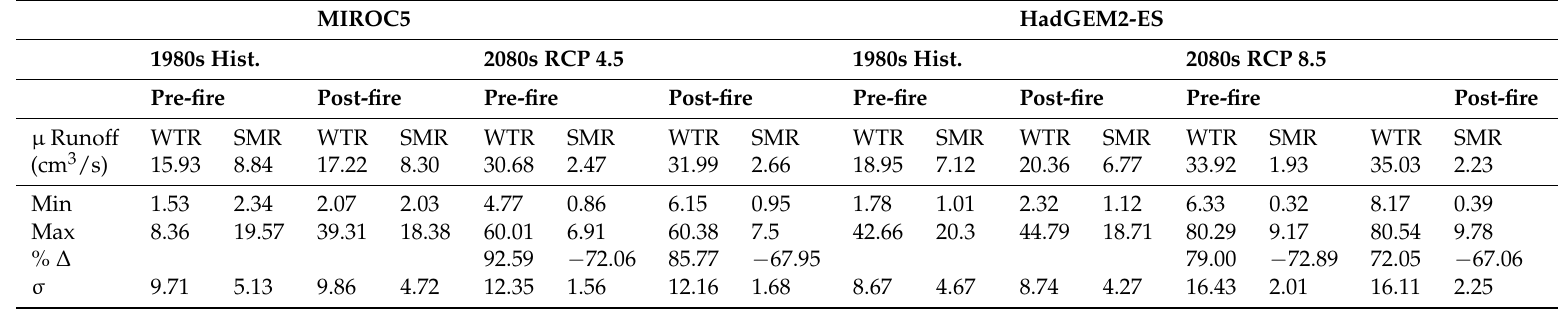
Table 4. Seasonal flows before and after forest cover reduction in the 1980s and 2080s for MIROC5 in RCP 4.5 and HadGEM2-ES in RCP 8.5. MIROC5 HadGEM2-ES 1980s Hist. 2080s RCP 4.5 1980s Hist. Post-fire Pre-fire Post-fire Pre-fire Post-fire Pre-fire Post-fire